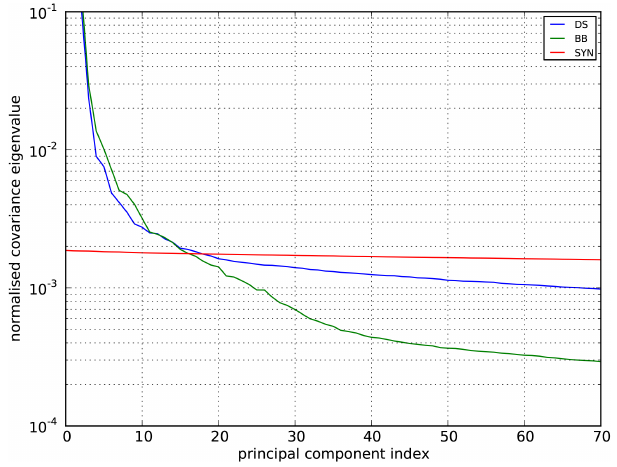
Figure 10. Normalised covariance eigenvalues of a DS, BB, and synthetic white noise data set. The eigenvalues indicate the rate at which each successive principal component adds to the total vari- ance.